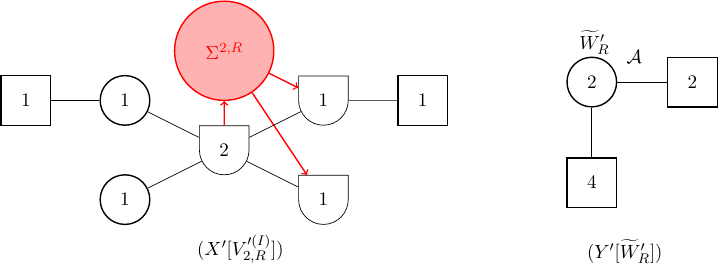
Figure 48 . A 3d-1d system which realizes a vortex defect in the flavored b D 4 quiver, and the dual Wilson defect in a U(2) gauge theory.